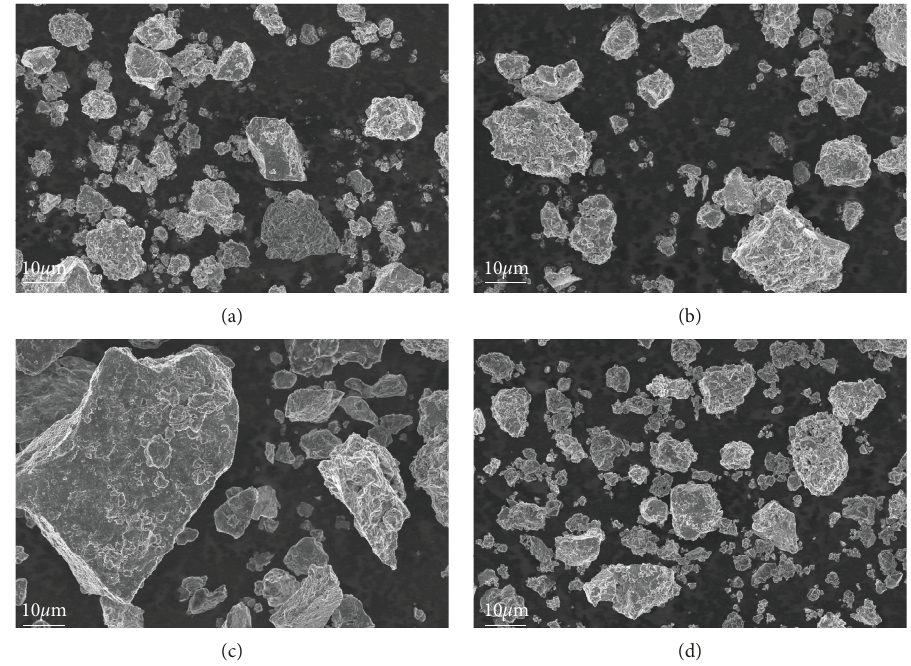
Figure 5: SEM image of HCX-2 ball milling: (a) 7 h; (b) 9 h; (c) 11h; (d)